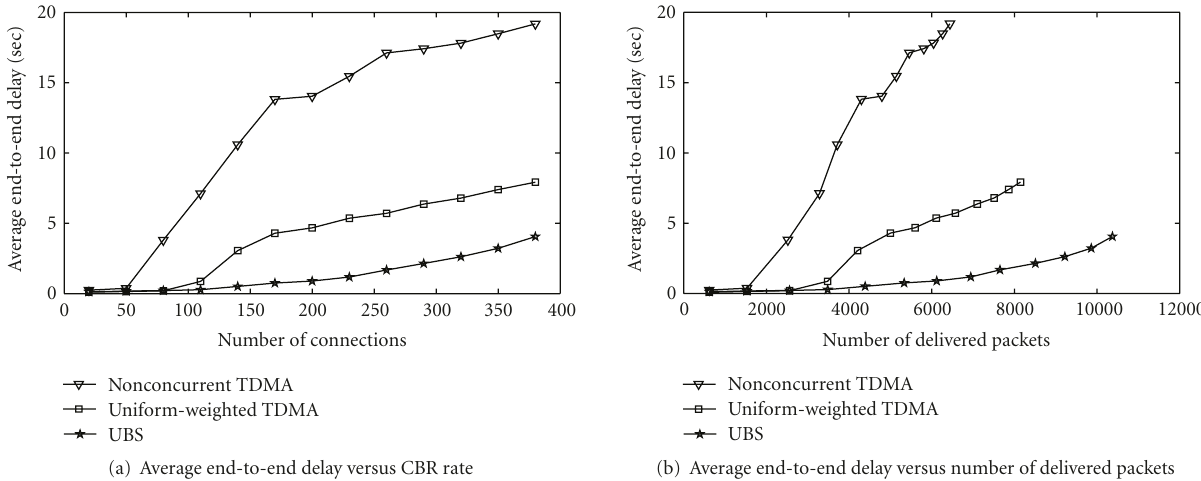
Figure 8: End-to-end packet delays in nonuniform tra ffi c scenarios averaged over 10 di ff erent 20-node network topologies.